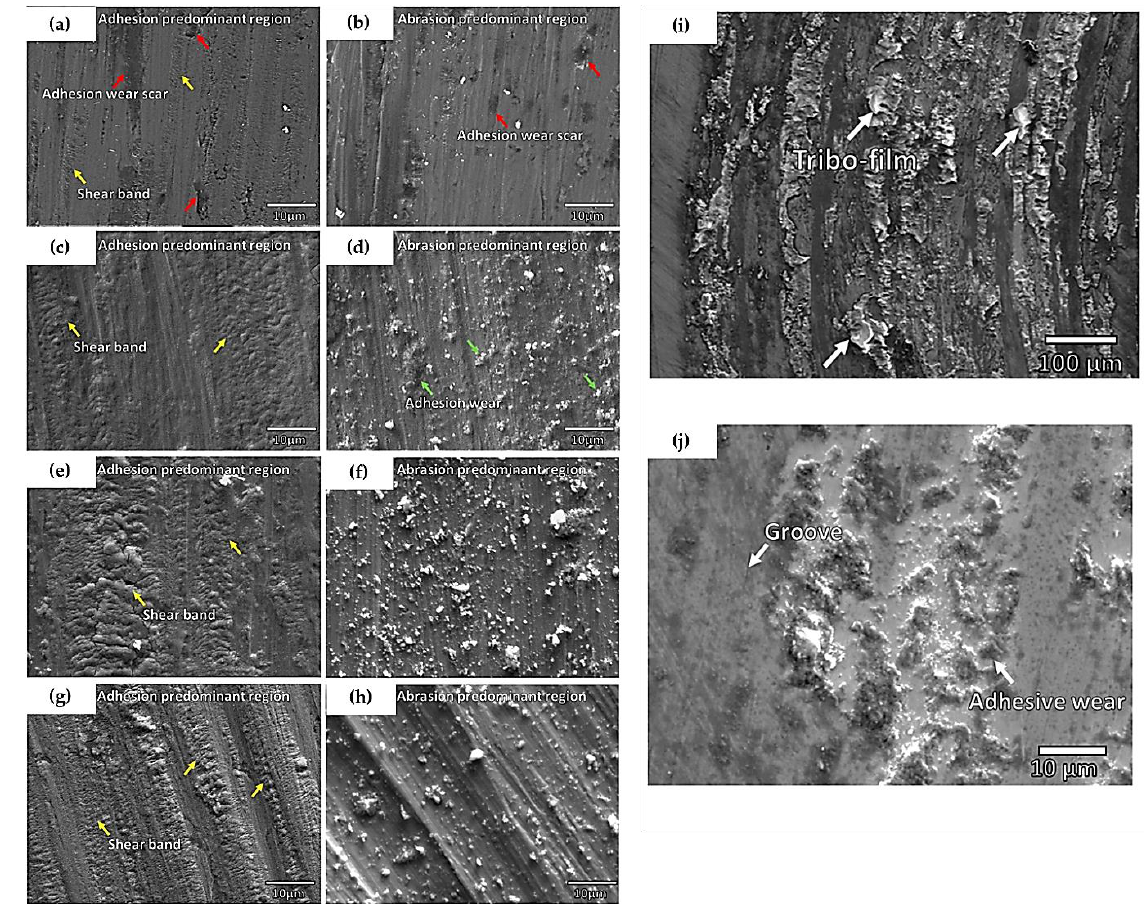
Figure 17. The wear track morphologies of CS IN 718 deposit subjected to dry room temperature conditions at a load of 5 N and sliding velocities of ( a , b ) 2 cm/s, ( c , d ) 4 cm/s, ( e , f ) 6 cm/s, and ( g , h ) 8 cm/s. Additionally, the wear track morphology of CS IN 713C deposit ( i , j ) is shown. In ( a – h ), the yellow arrows indicate shear bands, whereas the red and blue arrows indicate abrasive wear and adhesive wear. In ( i , j ), the white arrows indicate grooves, adhesive wear, and the formation of tribo-films. All images are reprinted from Wu et al., Copyright 2021 [79], under CC BY